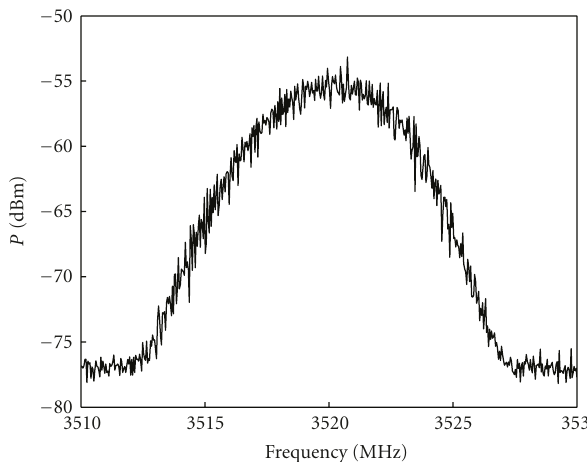
Figure 3: Trace of the WiMAX signal as a function of the frequency measured by the spectrum analyser at NLOS